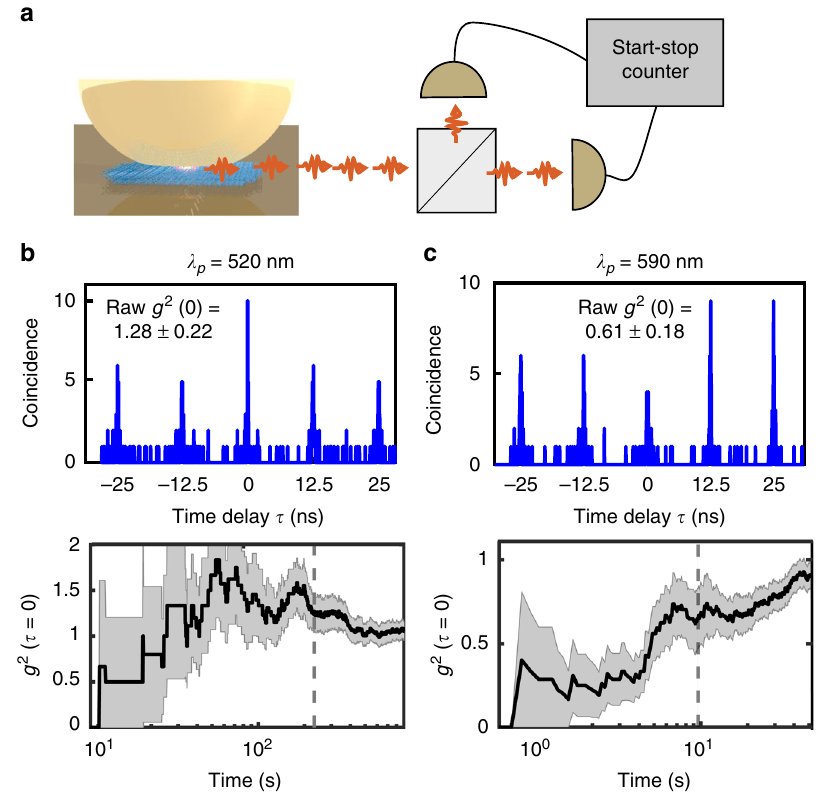
Fig. 4 Photon correlation measurement. a Scheme of experiment using tunable 120 fs pulsed excitation. b , c Second-order intensity correlation of the emission light from single Atto647 molecule inside NPoM cavity using b 520 nm and c 590 nm excitation wavelengths. Bottom panels show evolution of g 2 (0) vs measurement time. Black dashed line shows time at which upper panels are